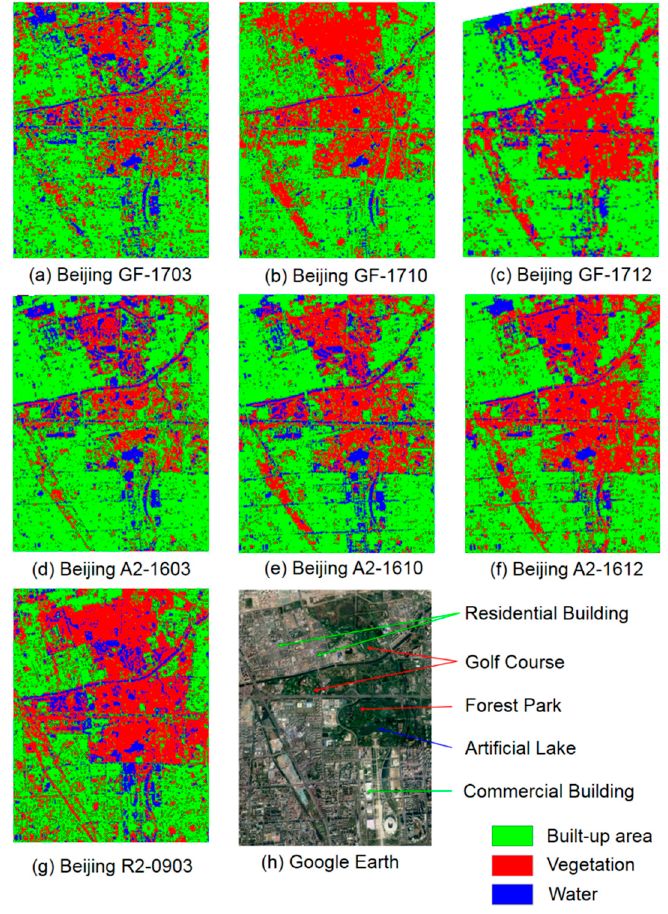
Figure 10. Classification of built-up areas, vegetation, and water in Beijing.